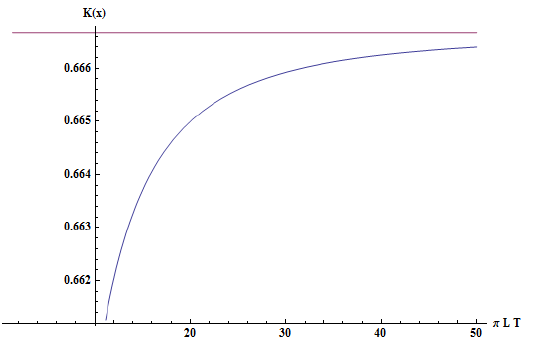
Figure 2 . Plot of the function K D 7 ( x ) starting from the minimum value x min = orange line is the value to which it asymptotes, namely 2 =